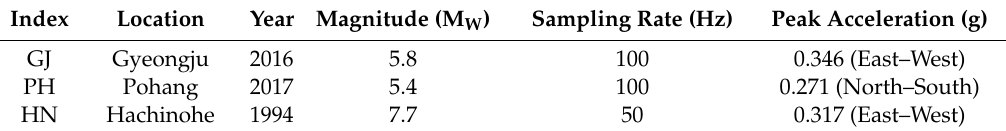
Table 1. Summary of earthquake events used.